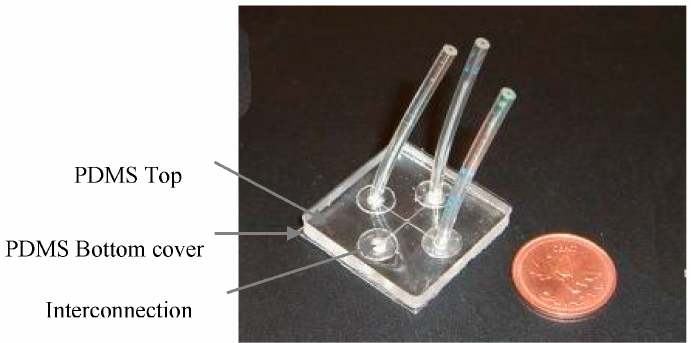
Figure 2. Fabricated and packaged polymer based microfluidic chip.